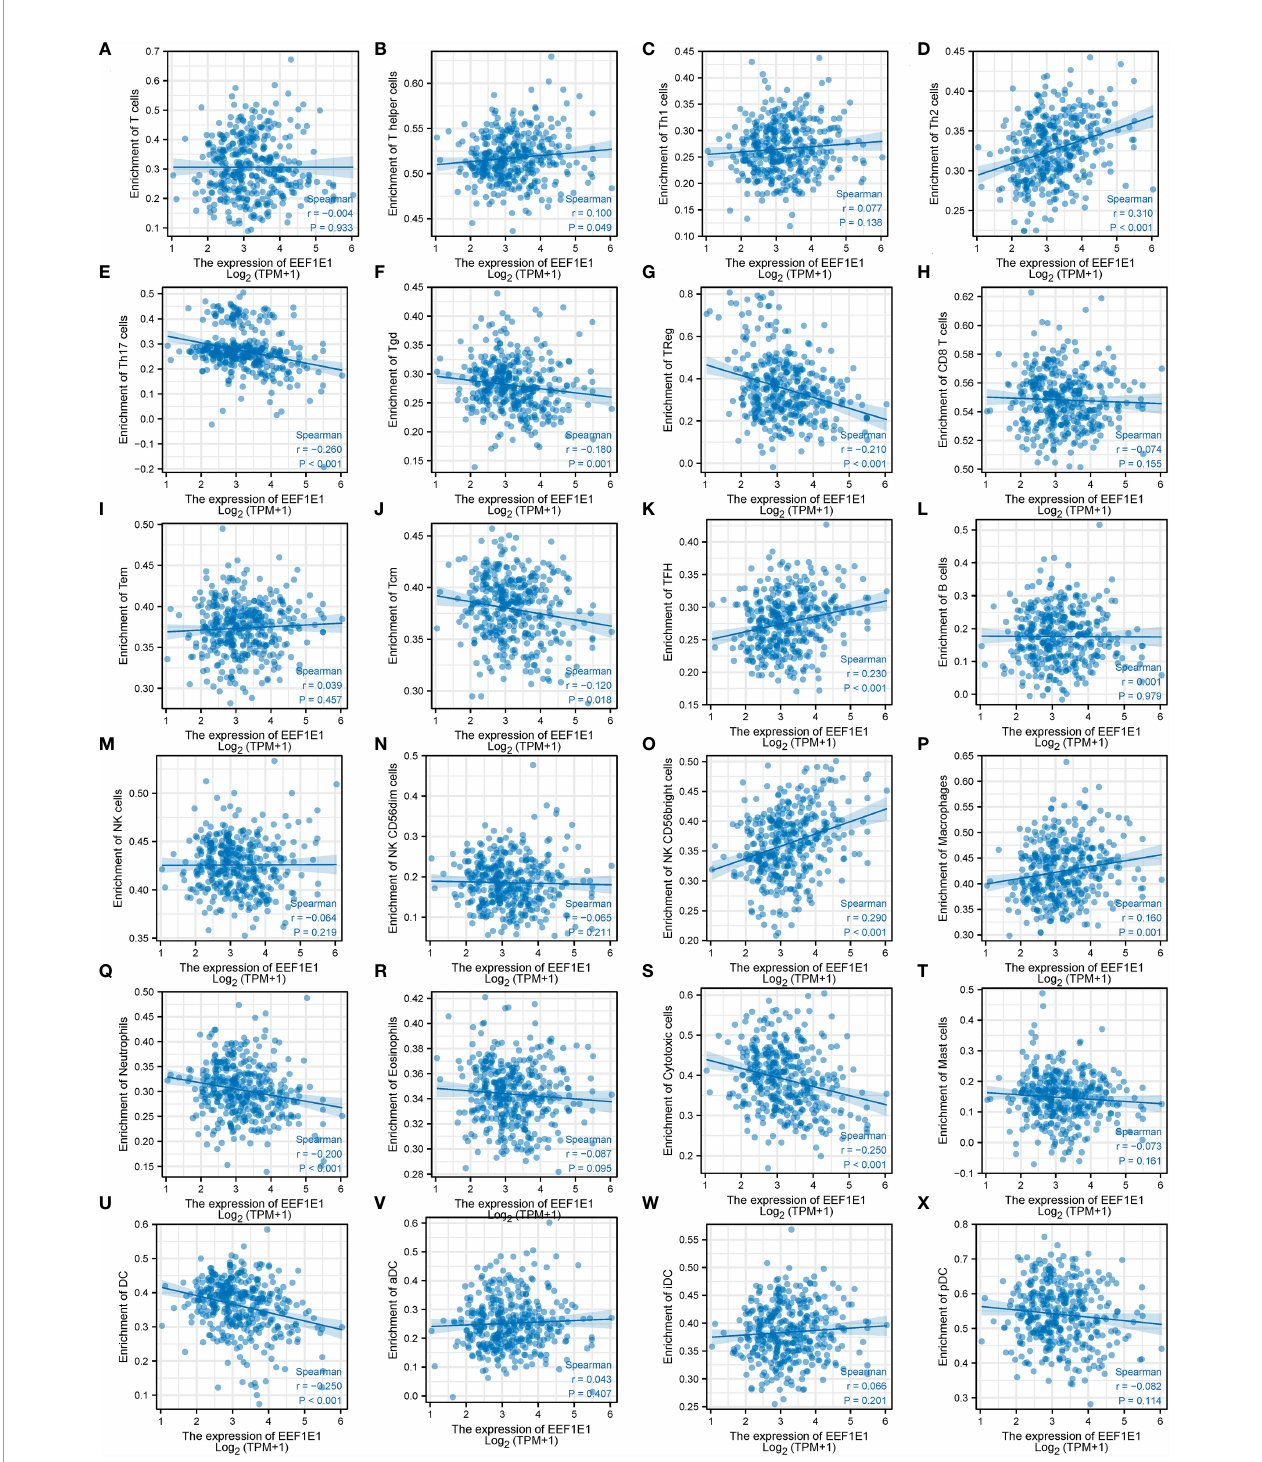
FIGURE 7 | Correlation between expression of EEF1E1 and immune in fi ltration (continued). (A – K) Correlation between expression of EEF1E1 and kinds of T cells in fi ltration. (L) Correlation between expression of EEF1E1 and B cells in fi ltration. (M – O) Correlation between expression of EEF1E1 and kinds of NK cells in fi ltration. (P) Correlation between expression of EEF1E1 and macrophages in fi ltration. (Q) Correlation between expression of EEF1E1 and neutrophils in fi ltration. (R) Correlation between expression of EEF1E1 and eosinophils in fi ltration. (S) Correlation between expression of EEF1E1 and cytotoxic cells in fi ltration. (T) Correlation between expression of EEF1E1 and mast cells in fi ltration. (U – X) Correlation between expression of EEF1E1 and kinds of DCs in fi